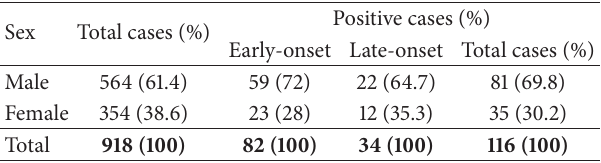
Table 1: Sex-wise distribution of total and septicemic cases.